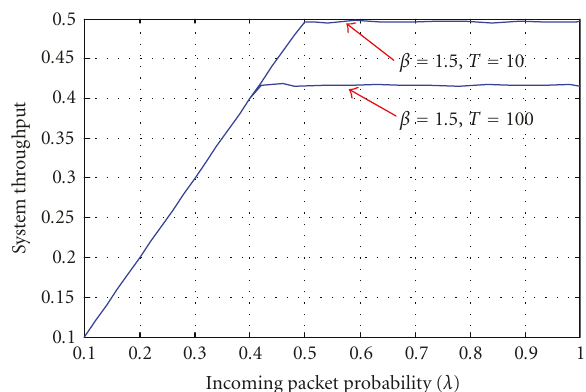
Figure 9: System throughput versus packet arriving probability ( β = 1 .